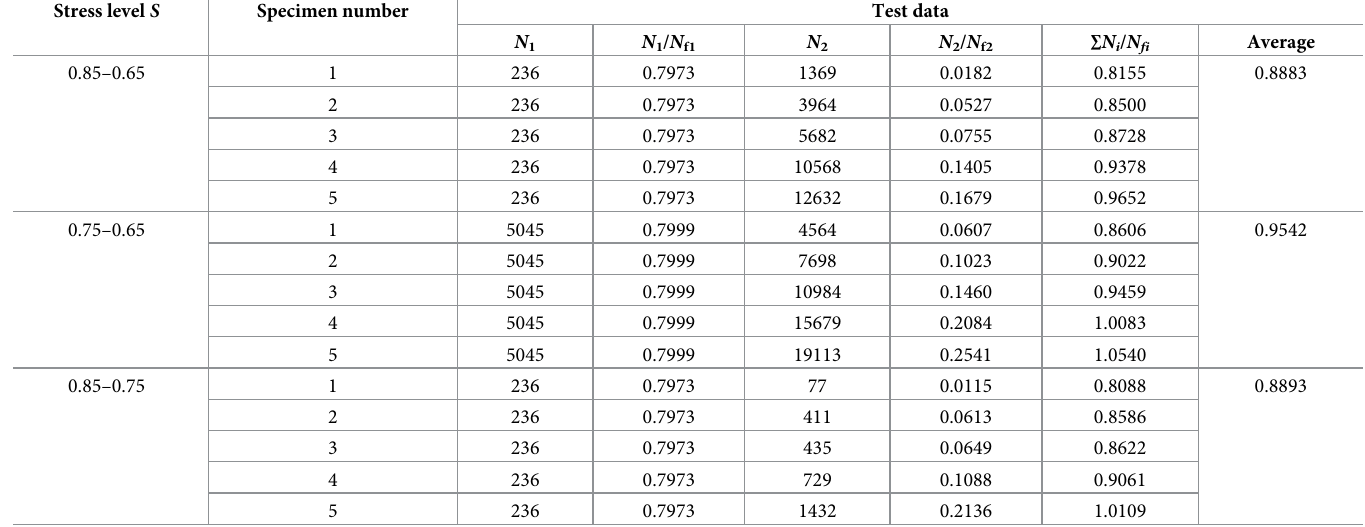
Table 13. Test results of flexural fatigue damage of concrete under two-stage loading (high-low order). Stress level S